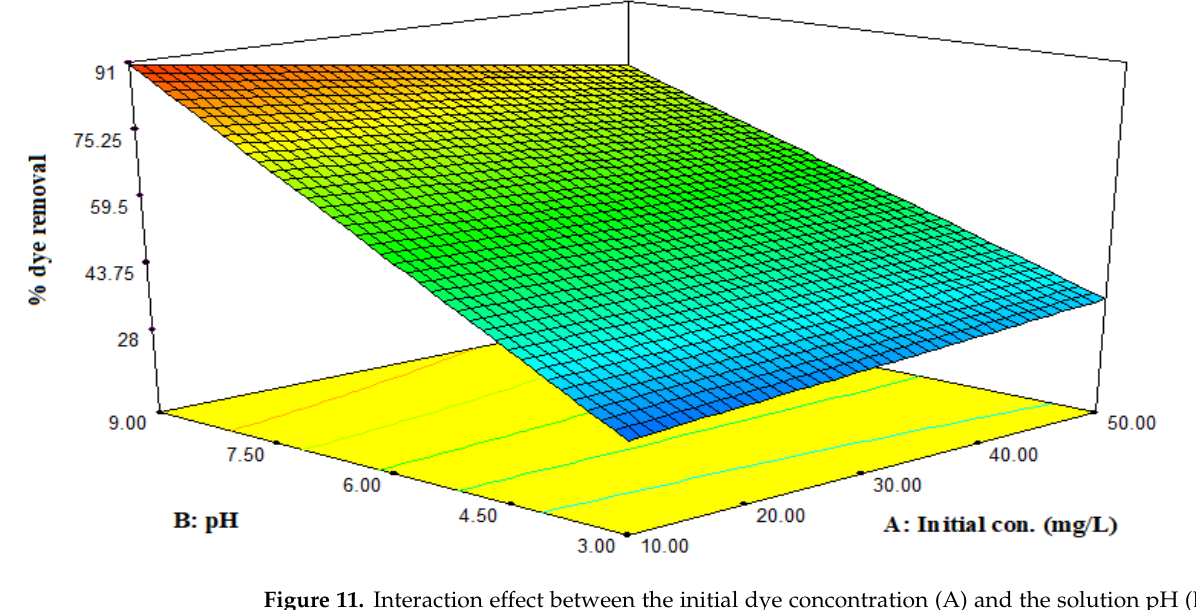
Figure 11. Interaction effect between the initial dye concontration (A) and the solution pH (B) on the perecentage dye removal at a constant contact time (D) of 89.75 min and adsorbent dose (C) of 200 (mg/L).